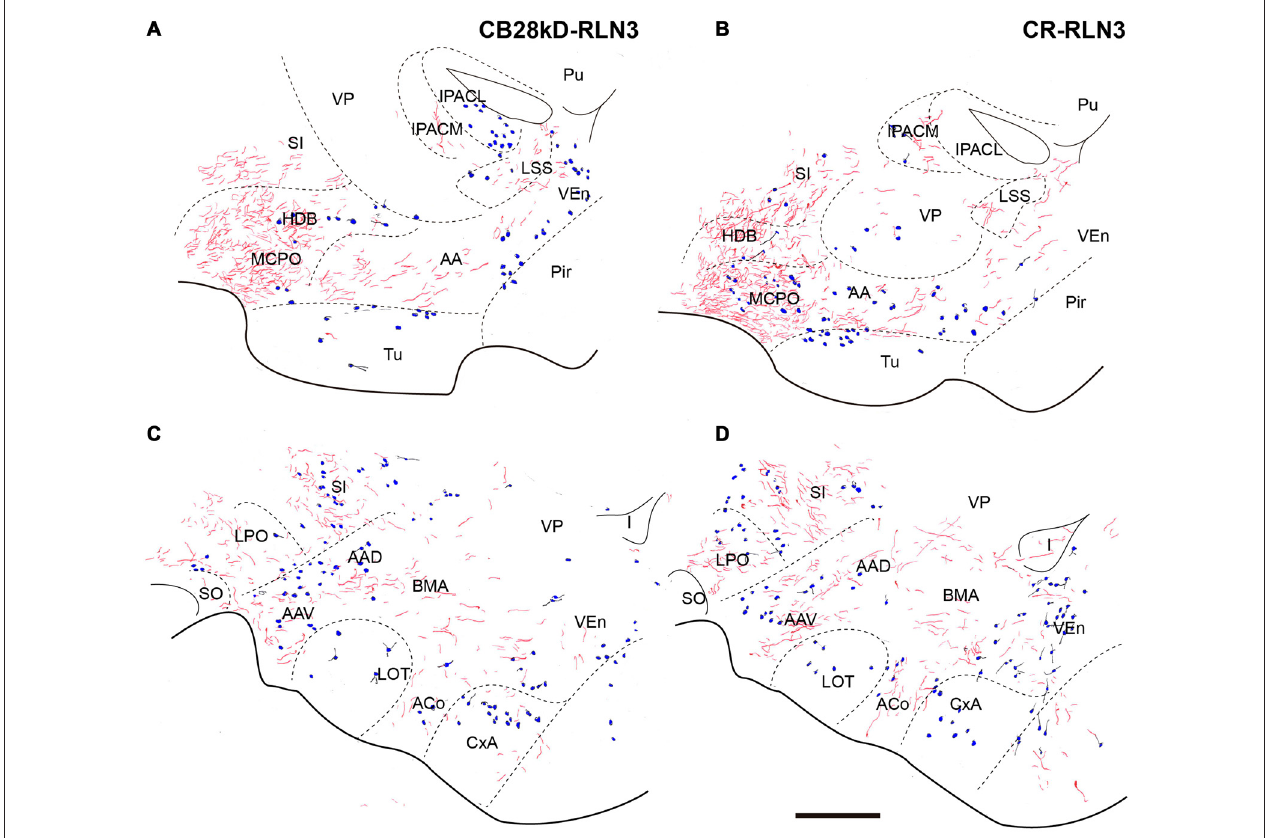
FIGURE 9 | Distribution of relaxin-3-positive fibers in the SLEA relative to the distribution of CB28kD-positive neurons (A,C) and CR-positive neurons (B,D) . Calibration bar 250 µ m.